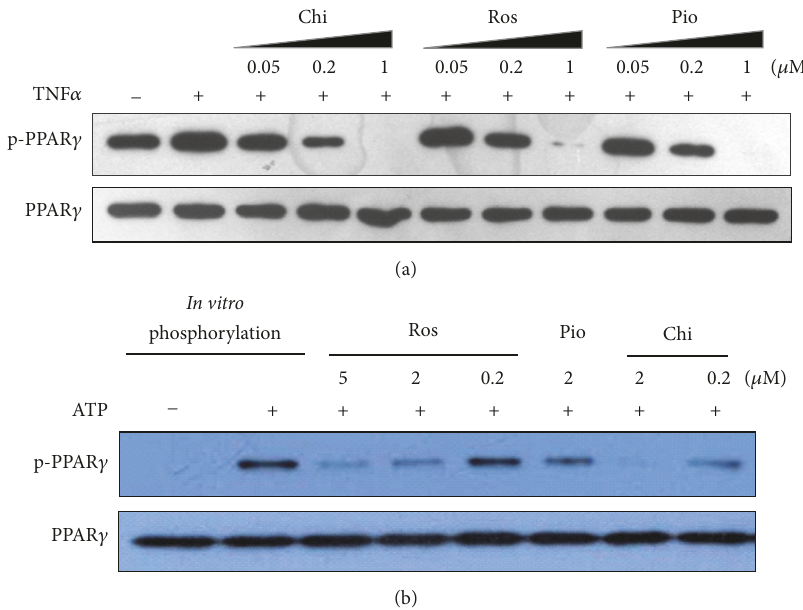
Figure 4: Chiglitazar inhibited TNF 𝛼 -induced and CDK5-mediated phosphorylation of PPAR 𝛾 . (a) HPA-v cells were cultured in 10cm plates and incubated with each agonist at the indicated concentration in the presence or absence of TNF 𝛼 (5 ng/ml). Cells were lysed and then subjected to immunoprecipitation (IP) with primary anti-PPAR 𝛾 antibody followed by SDS-PAGE and immunoblot analysis as described in Materials and Methods . (b) In vitro phosphorylation was performed using purified active CDK5/p25 (5ng/mL) and purified recombinant human PPAR 𝛾 -LBD. Chi, Ros, and Pio were added to the reaction, respectively, at the indicated concentrations in presence of TNF 𝛼 (5ng/ml) and then incubated for 30 minutes at 30 ∘ C. Immunoblot analysis was performed to determine the levels of the specified